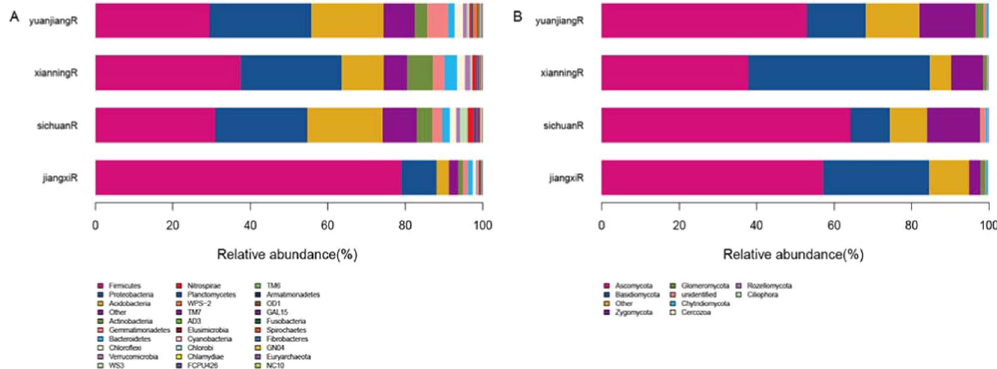
Figure 1. Relative abundance of the dominant bacterial ( A ) and fungal ( B ) taxa in four different area continuous cropping ramie soil samples at the phylum level. which were identified using the RDP classifier. Sequences not classified into any known group were designated as